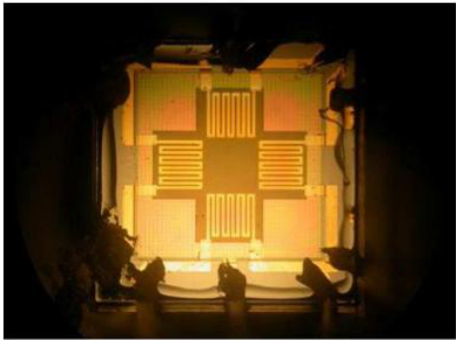
Figure 6. Nickel resistors arranged in bridge formation for air flow sensing on Si membrane for thermal isolation [41].